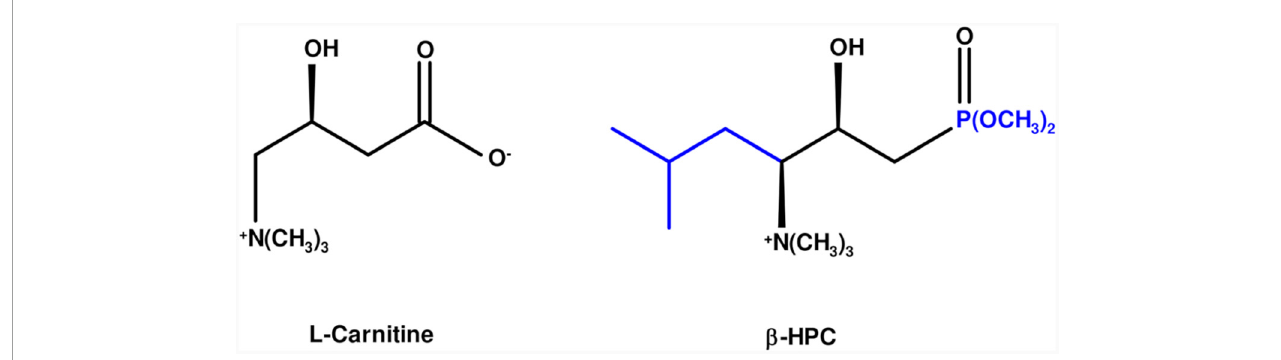
FIGURE1 Molecular comparison of L-carnitine and β -HPC. On the left, in the black line structure, L-carnitine is shown as an amino acid derivative with seven carbons, a carboxylate, and a quaternary amino group. On the right, the additions and changes to β -hydroxyphosphocarnitine or β -hydroxy- γ -aminophosphonate are shown in blue: five carbons, a phosphonate in carbon one and an isopropyl group in carbon 4.